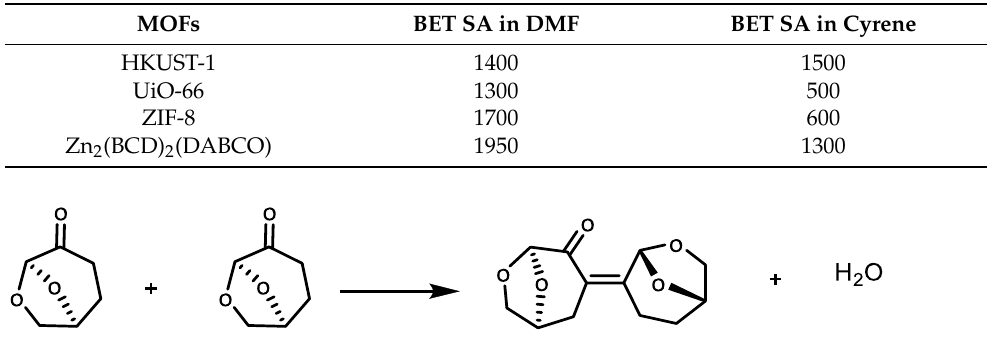
Table 4. BET surface area of different MOFs.